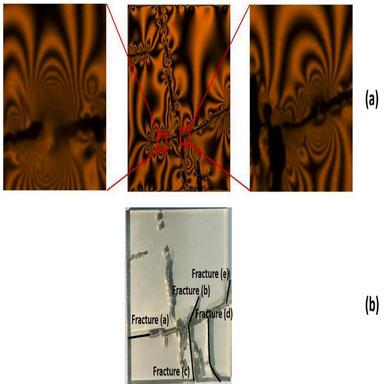
(a) Plastic concentration zone and (b) the failure pattern of the coal specimen. The copyright permission for this figure has been granted.